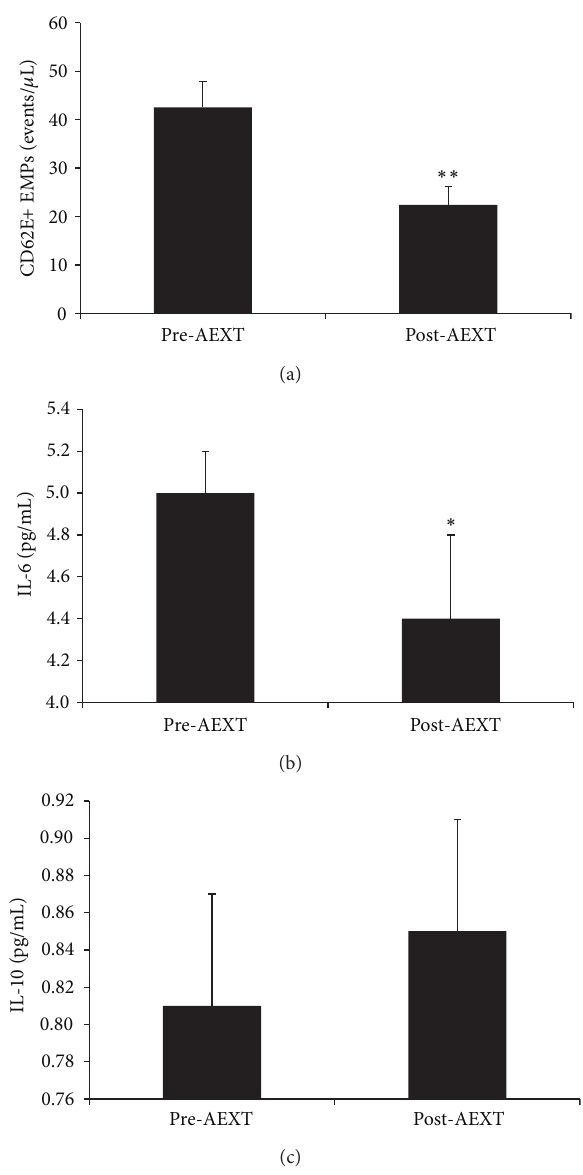
Figure 2: Inflammatory biomarkers before and after AEXT. The upper panel (a) shows CD62E+ EMPs pre- and post-AEXT. The middle panel (b) shows IL-6 pre- and post-AEXT. The lower panel (c) shows IL-10 pre- and post-AEXT. Bars are expressed as mean ± SEM. ∗ Denotes significant differences pre- versus post-AEXT; 𝑃 < 0.05 . ∗∗ Denotes significant differences pre- versus post-AEXT; 𝑃 < 0.01 .